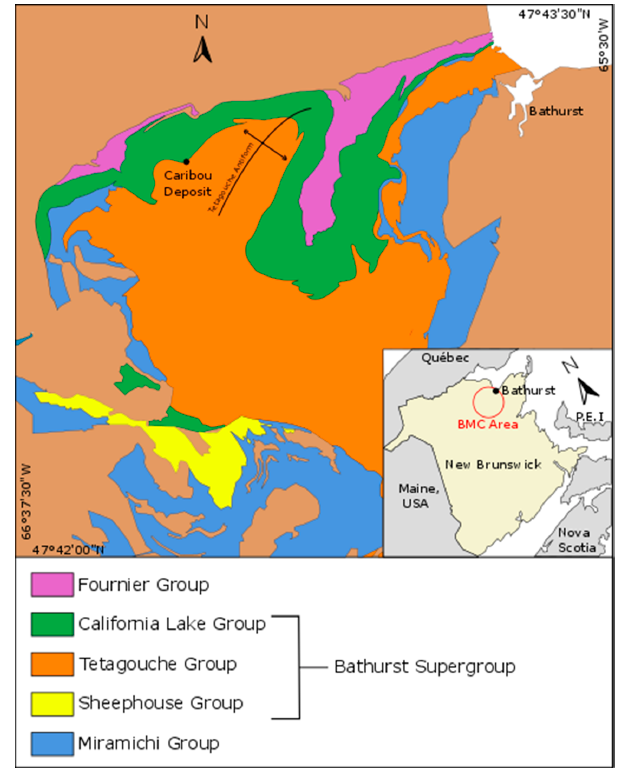
Figure 1. Simplified geology map of the Bathurst Mining Camp showing the location of the Caribou deposit and the five major rocks (modified from [1]). BMC, Bathurst Mining Camp. deposit and the five major rocks (modified from [1]). BMC, Bathurst Mining